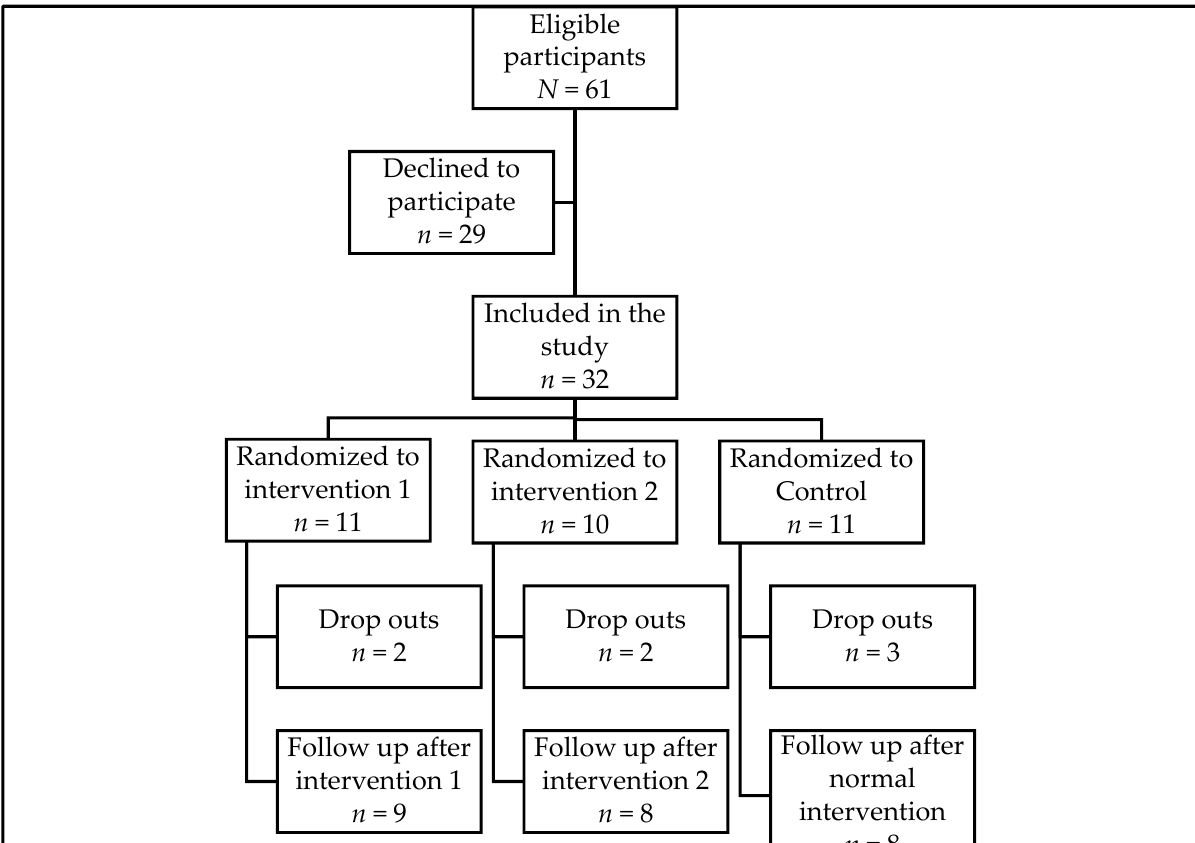
Figure 2. Flow chart of the study. Reasons for drop out were not known ( n = 5) and admission to hospital ( n = 2). Table 3. Median and interquartile range (IQR) for baseline measures for the total group and the total group divided into intervention groups 1 and 2 and the control group.